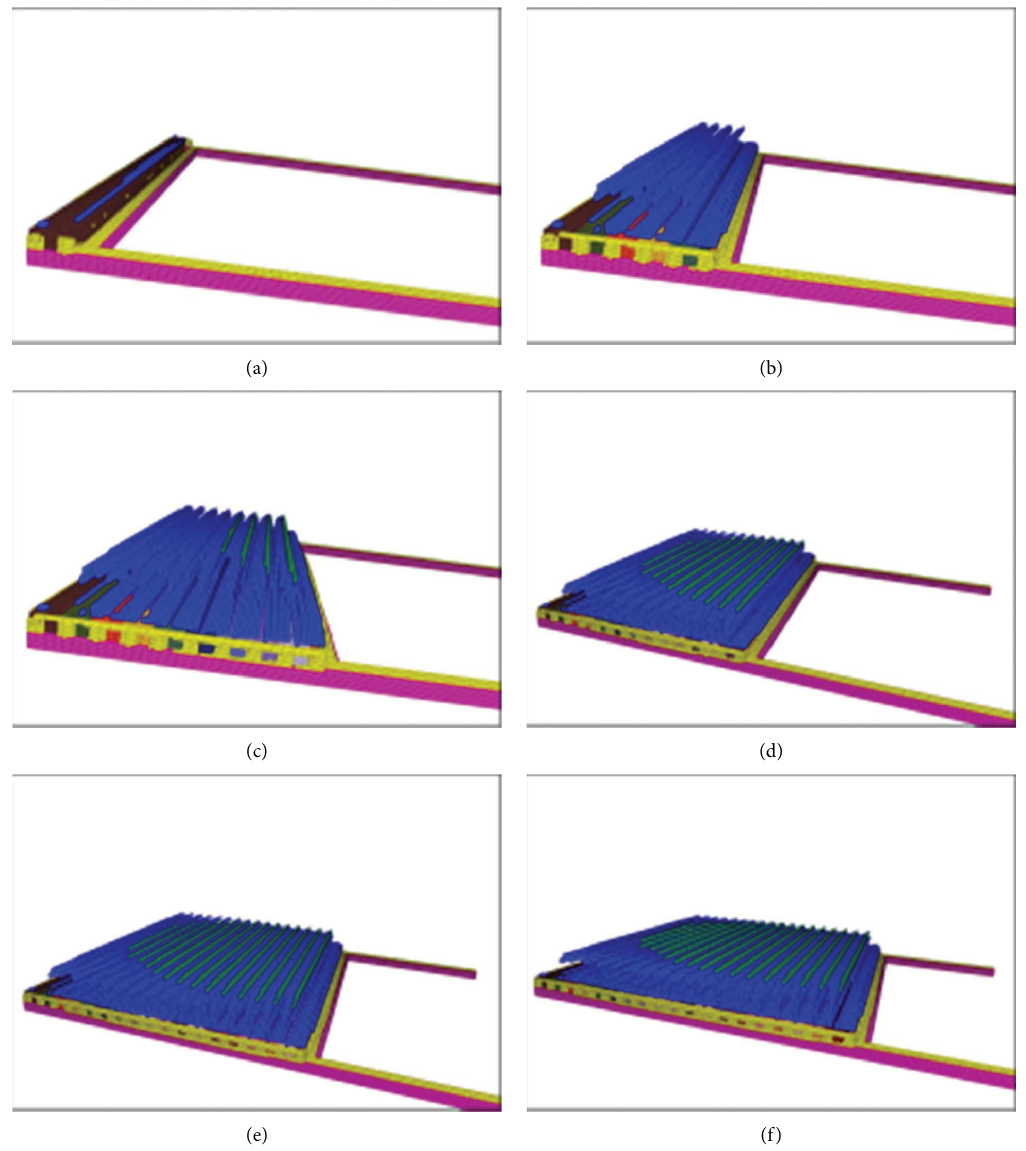
Figure 7: Overburden rock caving characteristics of ultra-high working face under diferent advancing distances: (a) advance 32m, (b) advance 96m, (c) advance 160m, (d) advance 224m, (e) advance 288m, and (f) advance